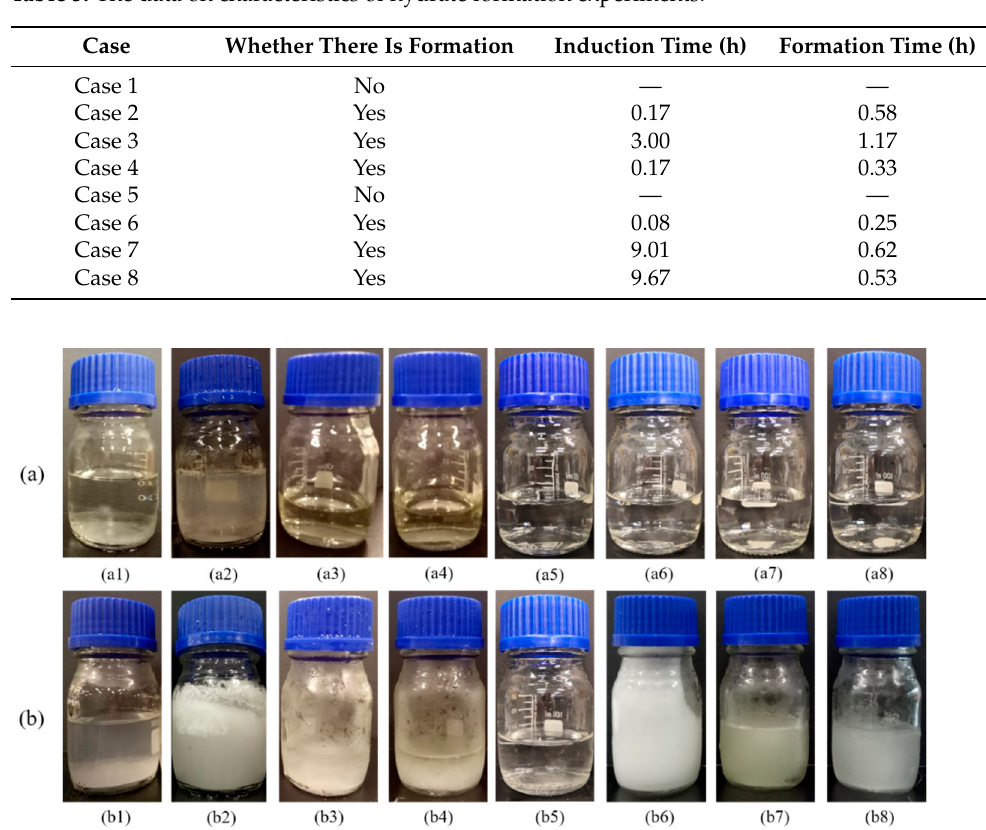
Figure 2. Comparison of three guest molecules before and after hydrate formation. ( a ) Before hydrate formation; ( b ) after hydrate formation; experimental conditions for hydrate formation by R141b in pure water (1), R141b with 1 cm 3 ice cube addition (2), TME in pure water (3), TME with 1 cm 3 ice cube addition (4), TBAB/TBAC in pure water (5), TBAB/TBAC with 1 cm 3 ice cube addition (6), TBAB/TBAC with 500 rpm stirring (7) and TBAB/TBAC with 500 rpm stirring and 0.1 g graphene addition (8).